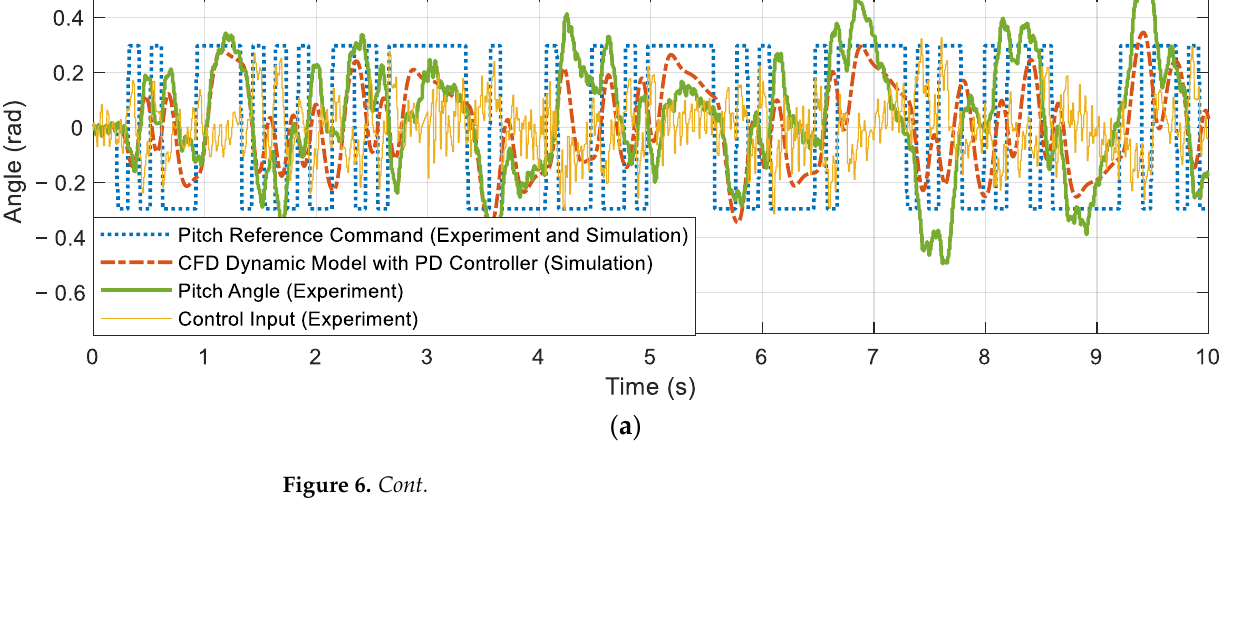
Figure 5. Experimental flight data and simulation results for system identification with regular square reference inputs: ( a ) pitch angle responses, and ( b ) pitch rate responses.